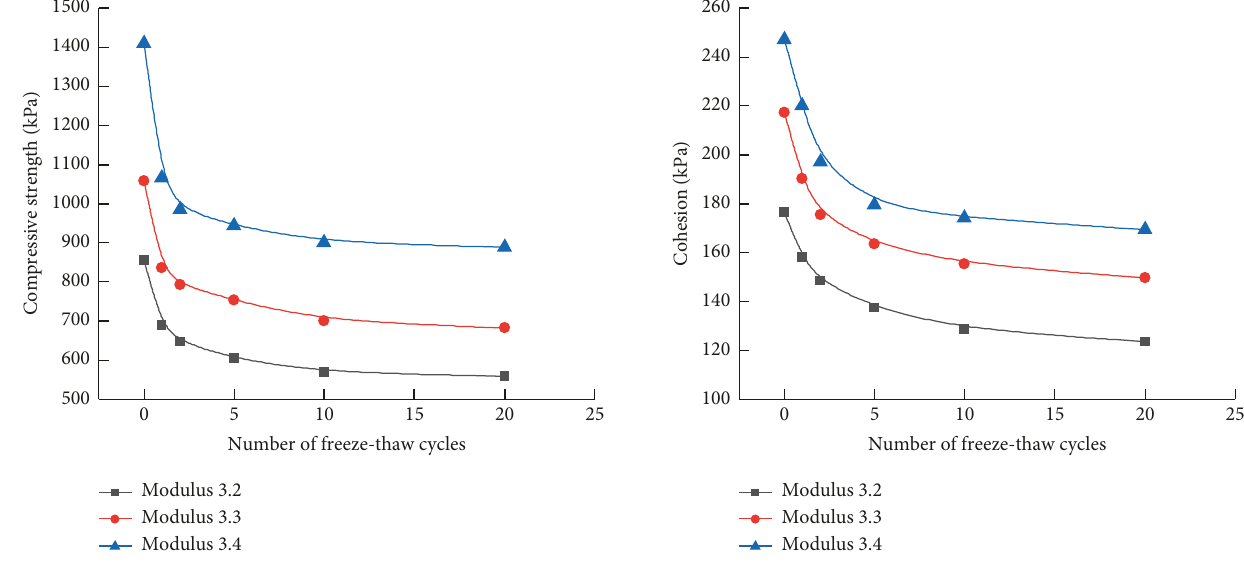
Figure 2: Compressive strength changes with the number of freeze-thaw cycles.